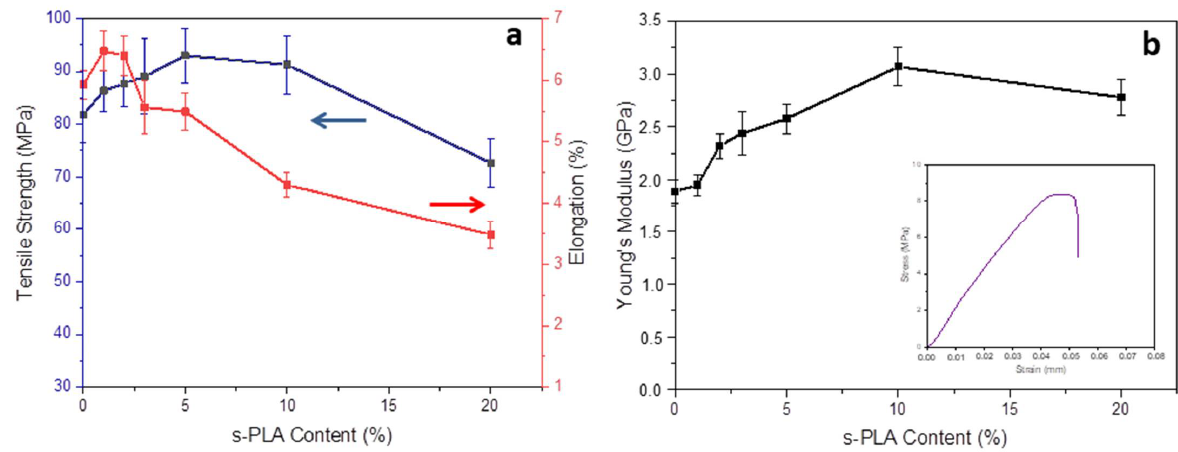
Figure 3. The mechanical properties of PLLA/PDLA blend with various s-PLA contents ( a ) tensile strength and elongation (%), ( b ) Young’s modulus (insert: Typical stress-strain curve). Table 3. The mechanical properties of PLLA/PDLA blends with different particle sizes of s-PLA. Materials Elongation at Break (%) Tensile Strength (MPa) Young’s Modulus (GPa)